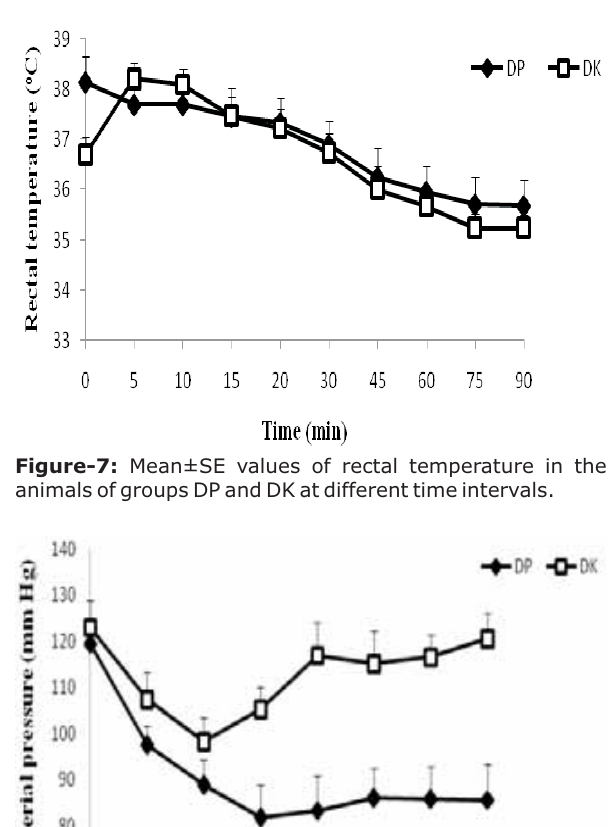
Figure-5: Mean±SE values of Heart rate in the animals of groups DP and DK at different time intervals.